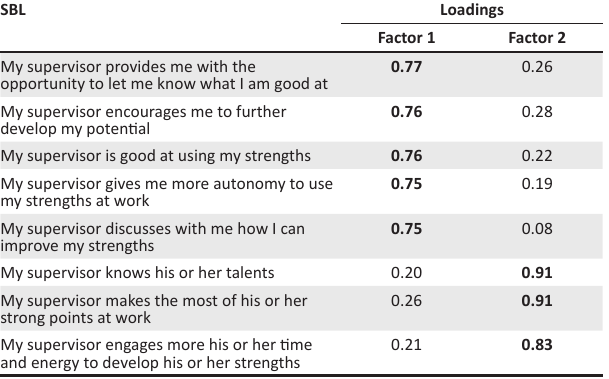
TABLE 1: Exploratory factor analysis of the strengths-based leadership